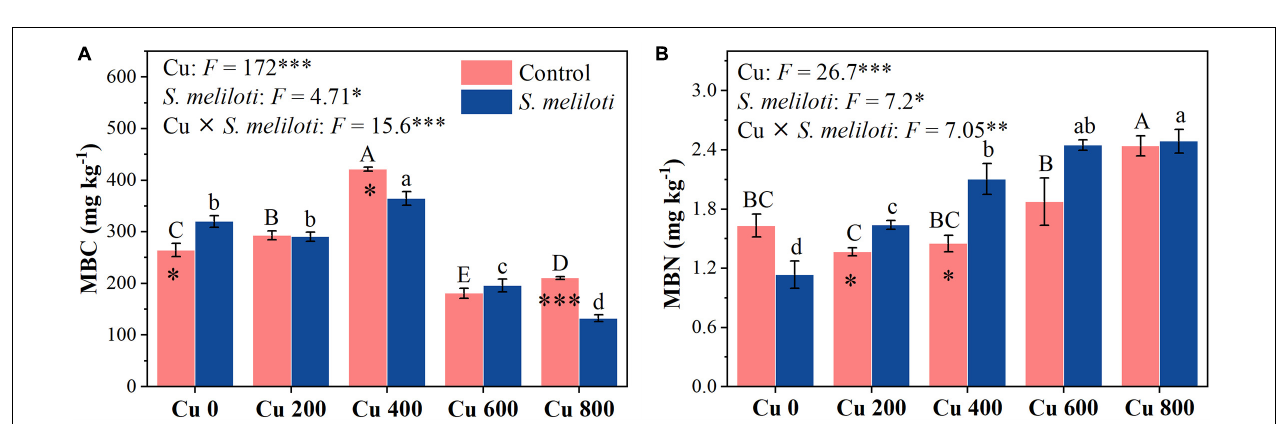
FIGURE 5 | The effect of inoculation with S. meliloti on soil enzyme activities under different Cu concentration treatments. The capitalized (Cu) and lowercase ( S. meliloti ) letters above the bars indicate significant difference between different Cu concentrations ( P < 0.05). The asterisks indicate significant differences between non-inoculated and inoculated alfalfa under the same Cu concentration condition. Each value represents the mean ± SE ( n = 3). *** P < 0.001; ** P < 0.01; * P < 0.05.